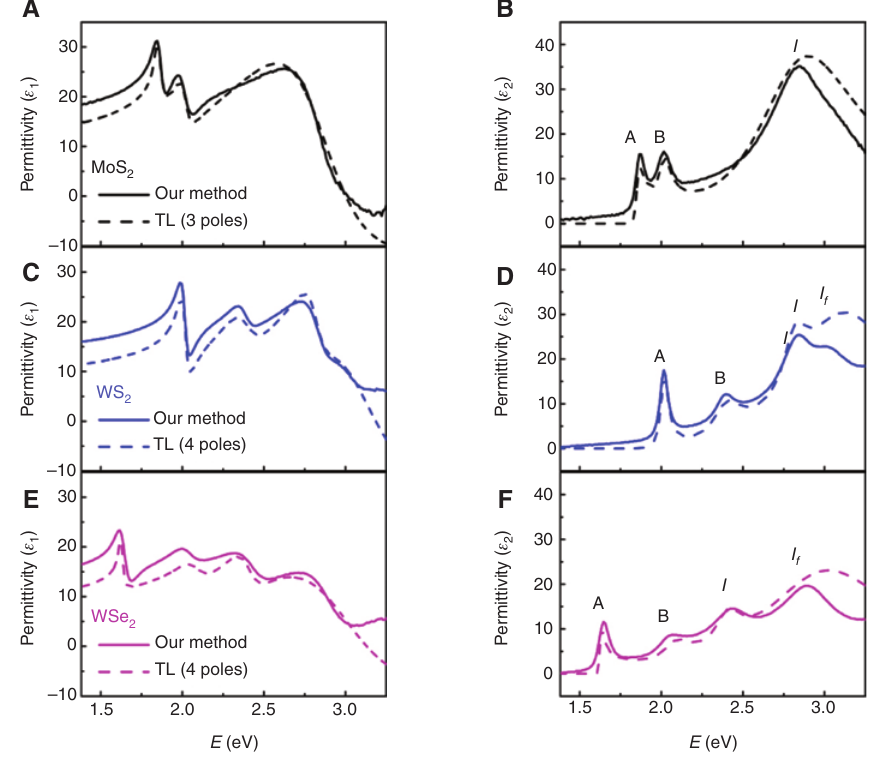
Figure 3: The permittivity of monolayer TMDCs. Real (left column) and the imaginary part (right column) of the permittivity of monolayers of (A, B) MoS and dashed lines, respectively, correspond to the data obtained by our method and by Tauc–Lorentz fitting with a limited number of poles (see Supporting Information for the tabulated data of the permittivity and the refractive index plotted in Figure 3).